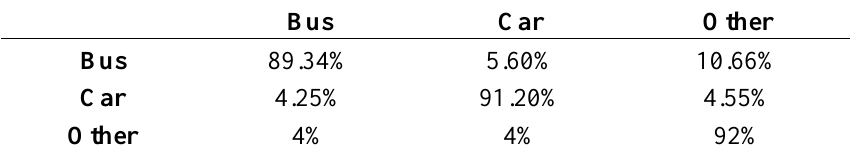
Table 4. Accuracy table of audio classification using our dataset [24].